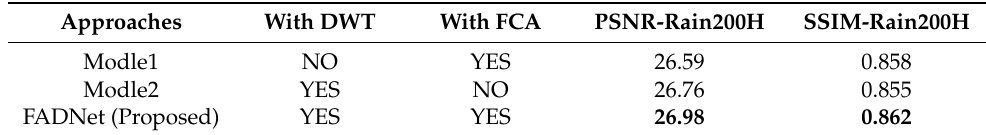
Table 2. Results of the ablation experiment for DWT and FCA modules.